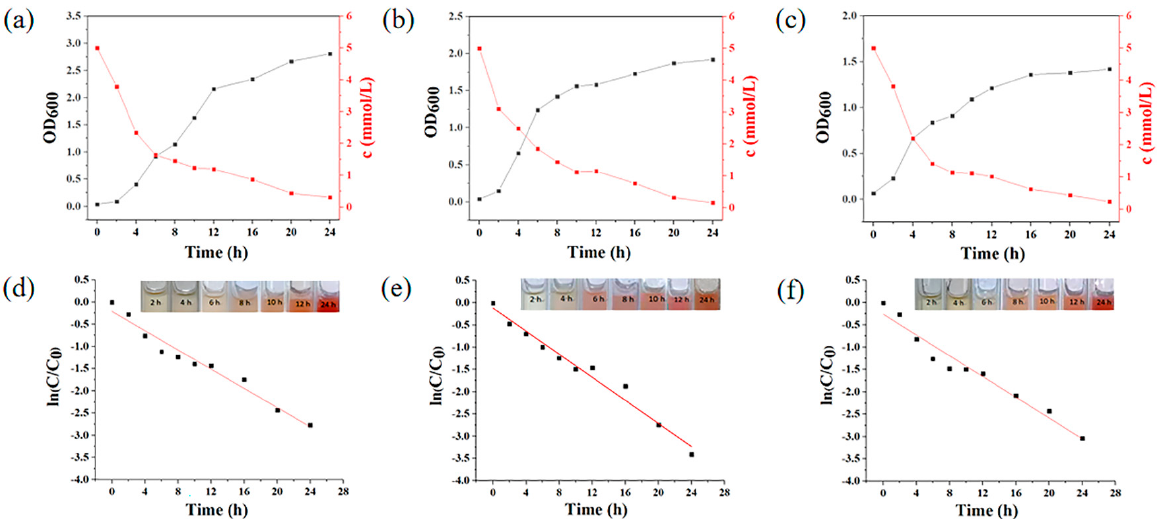
Figure 2. Time course of growth and SeO 32 − removal by three strains in LB medium supplemented with 5 mM NaSeO 3 . ( a ) Strain 72. ( b ) Strain 33. ( c ) Strain 21. The kinetic fitting curve of reduction reaction and color change of reaction system. ( d ) Strain 72. ( e ) Strain 33. ( f ) Strain 21.